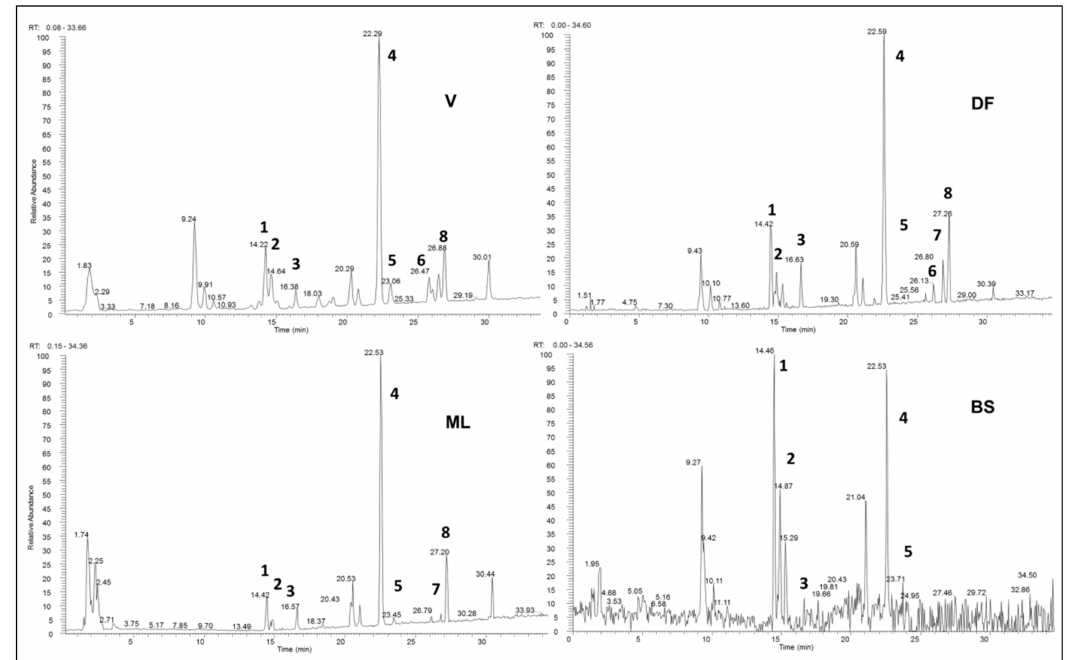
Figure 3. LC-ESI-Orbitrap-MS profiles of polyphenol and anthocyanin-rich extracts from pigmented tubers in negative ion mode. Note: V = “Vitelotte”; DF = “Double Fun”; ML = “Magenta Love”; BS = “Blue